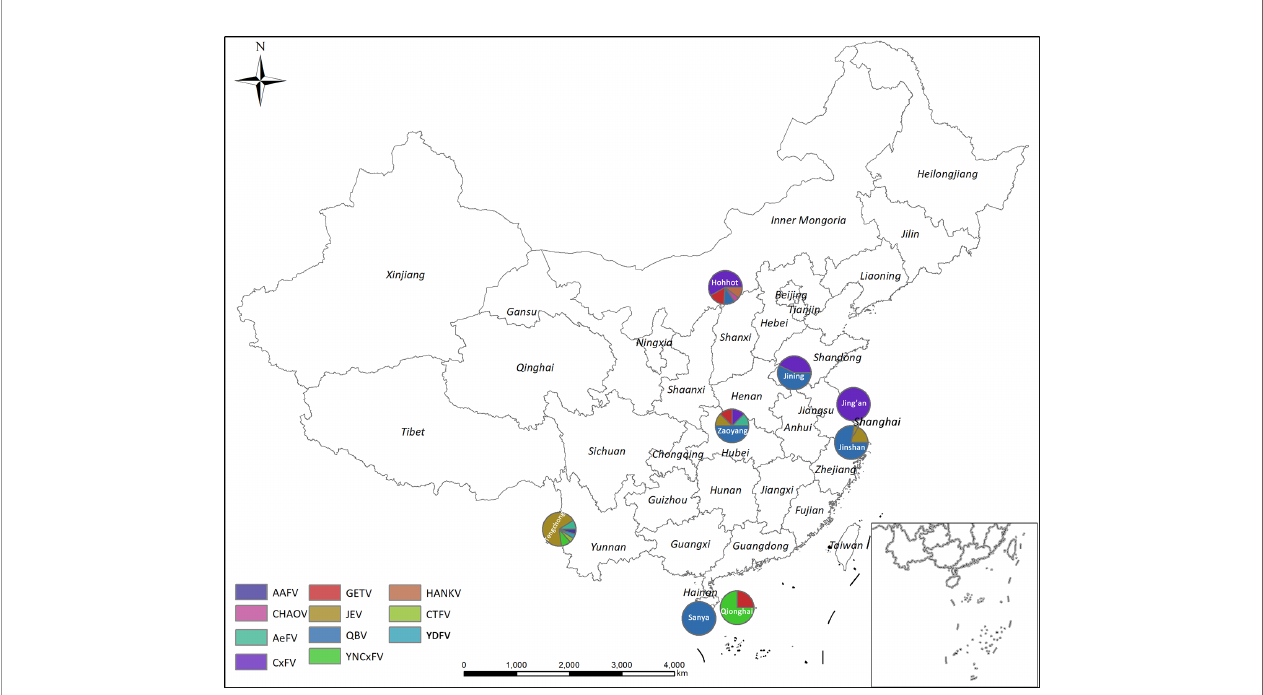
FIGURE 1 | Arbovirus distributions by mosquito pathogen surveillance sentinel site in China in 2018. AAFV, Anopheles-associated fl avivirus; AeFV, Aedes fl avivirus; CHAOV, Chaoyang virus; CTFV, Culex theileri fl avivirus; CxFV, Culex fl avivirus; HANKV, Hanko virus; JEV, Japanese encephalitis virus; QBV, Quang Binh virus; YDFV, Yamadai fl avivirus; YNCxFV, Yunnan Culex fl